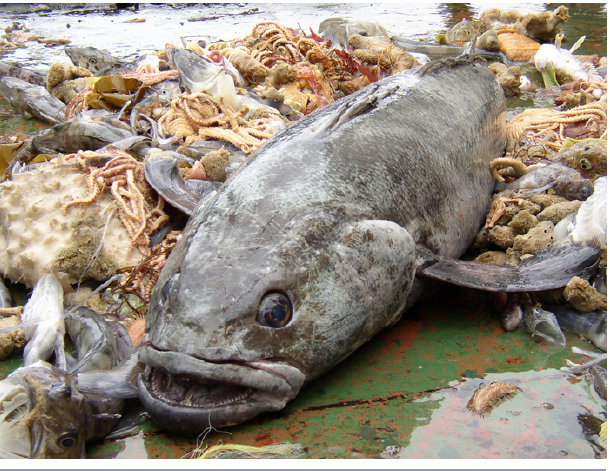
Fig. 4 . Licensed fishing for toothfish, including both Patagonian and Antarctic toothfish ( Dissostichus mawsoni